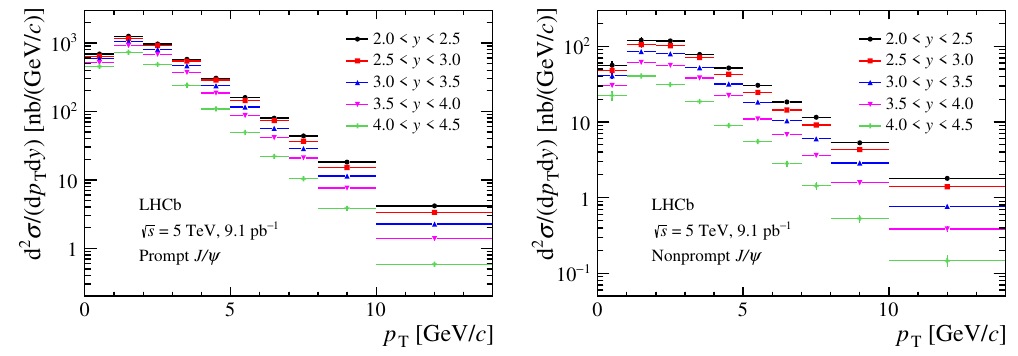
Figure 2 . Differential cross-sections for (left) prompt and (right) nonprompt J/ψ mesons as a function of p T in intervals of y . The error bars represent the total uncertainties, which are partially correlated between